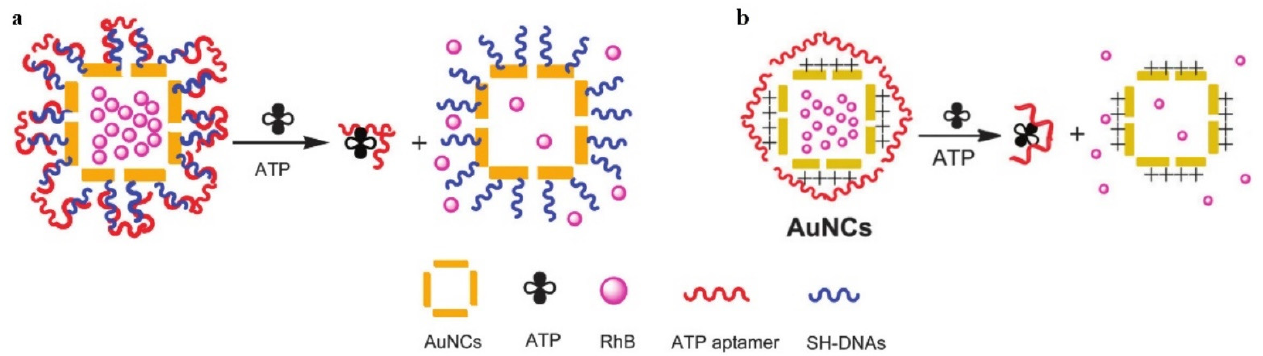
Figure 2. Schematic illustration of two kinds of ATP-responsive AuNCs for ATP detection. In the presence of ATP, specific recognition reactions selectively triggered the release of the encapsulated RhB. ( a ) ATP aptamers were capped on the surface of AuNCs via oligonucleotides; ( b ) ATP aptamers were capped on the surface of AuNCs via electrostatic interactions. Reprinted/adapted with permission from Refs. [40,41]. Copyright 2012 and 2015, respectively, The Royal Society of Chemistry.